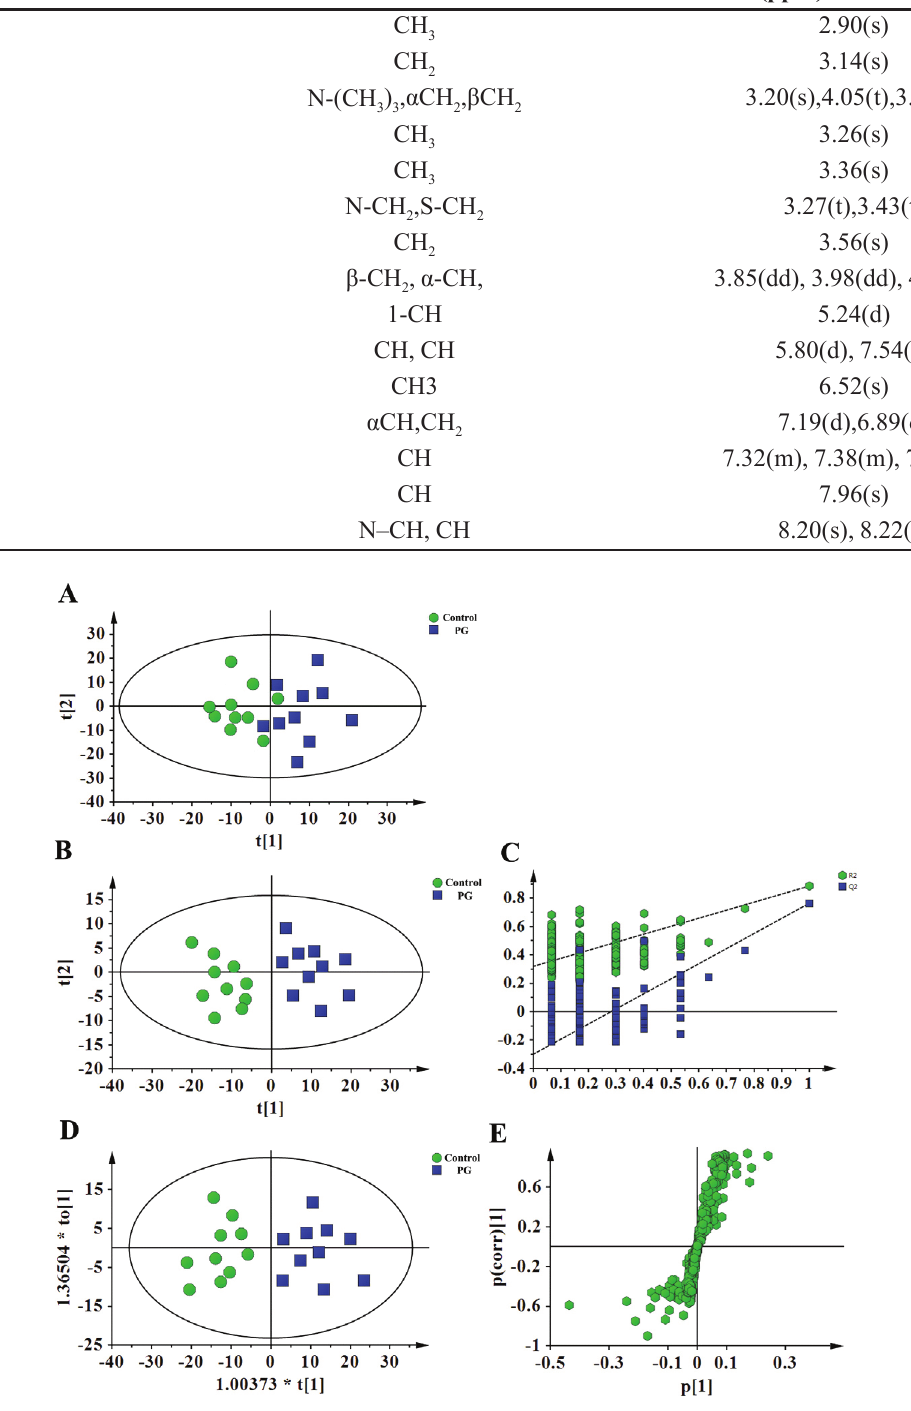
FIGURE 4 - Multivariate statistical analysis of 1 H‑NMR spectra data sets of the feces contents of weaned rats. Each point in A, B, and D represented one sample. A represented the PCA score of the 1 H‑NMR spectrum dataset of the cecal contents; B and C respectively represented the PLS‑DA model score and the permutation verification; D and E represented the score and load diagram of the OPLS‑DA model respectively. The original point in C represented the R 2 value of the model. The square point represented the model Q 2 value. Each point in E represented the chemical shift value with the integral